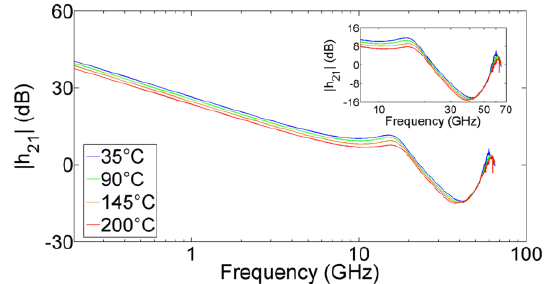
Figure 9. Measured h 21 from 0.2 to 65 GHz for a GaN HEMT at V DS = 30 V and V GS = − 3.1 V under four ambient temperatures: 35 °C, 90 °C, 145 °C, and 200 °C.